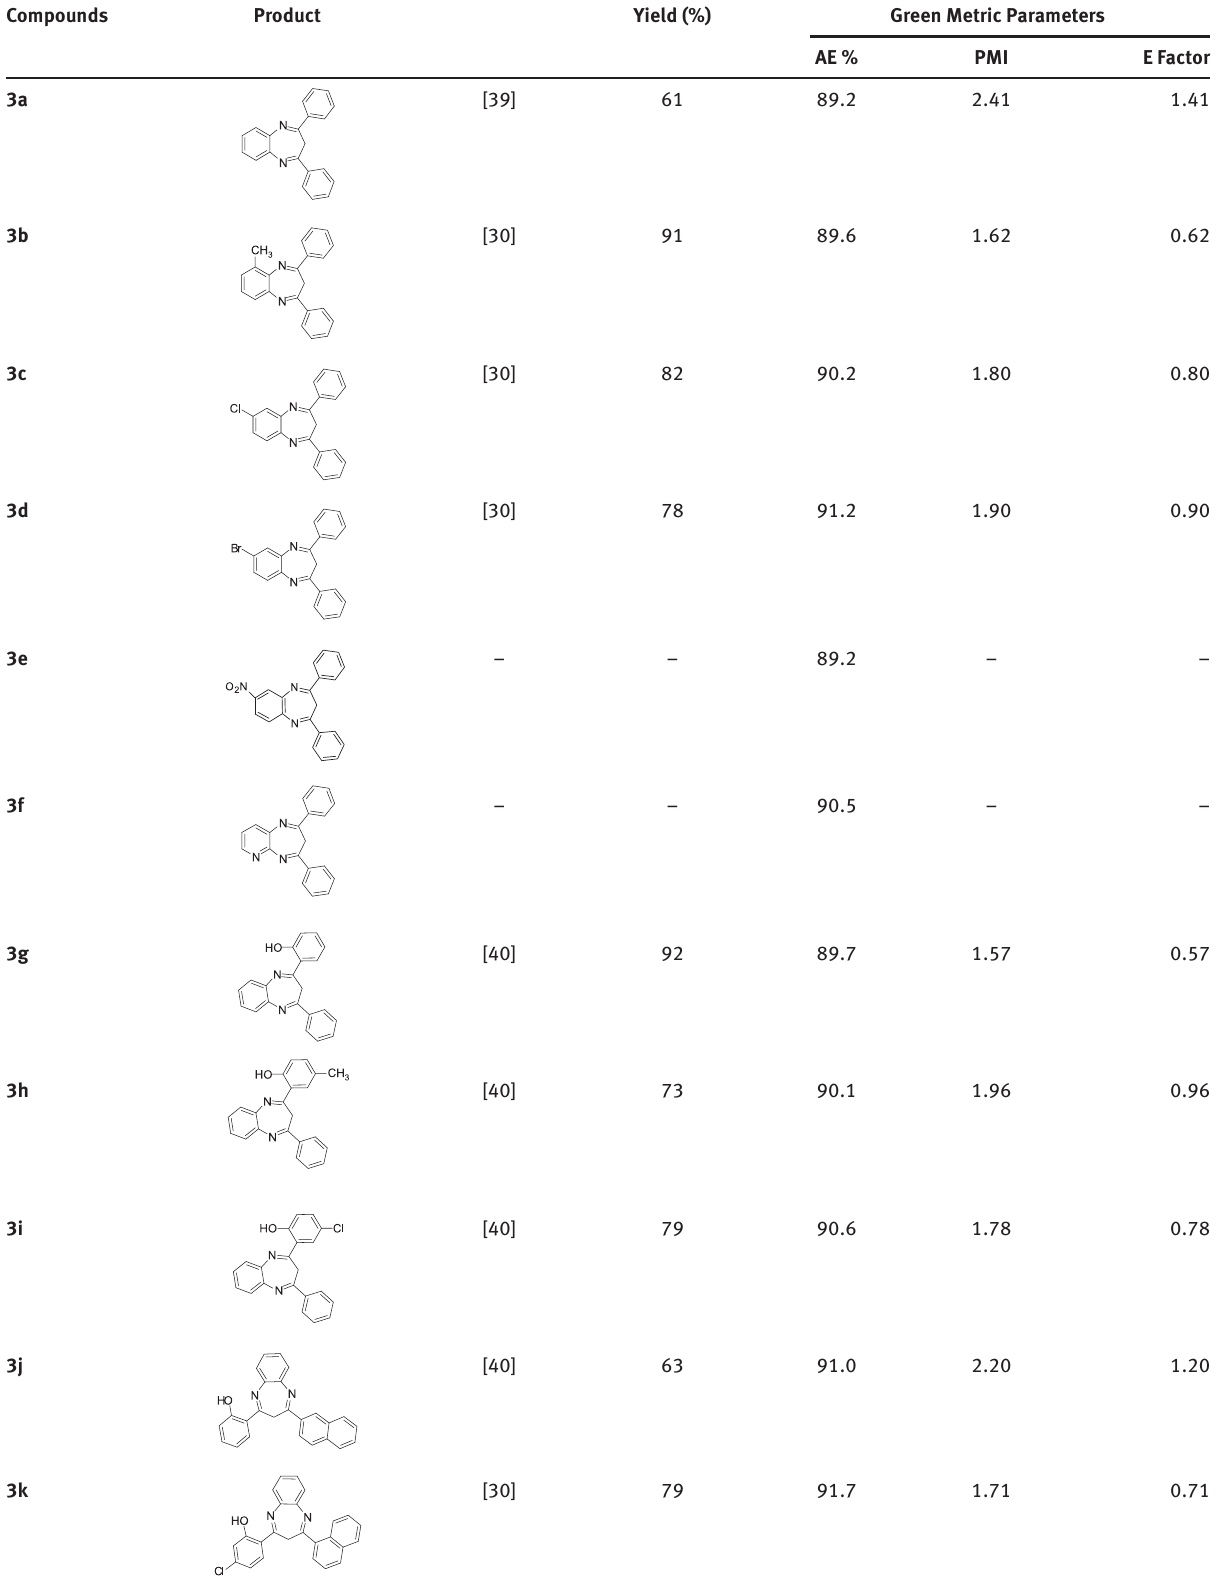
Table 9: Yield and Green Metric Parameters for the different substituted 3 H -1,5-benzodiazepines obtained.